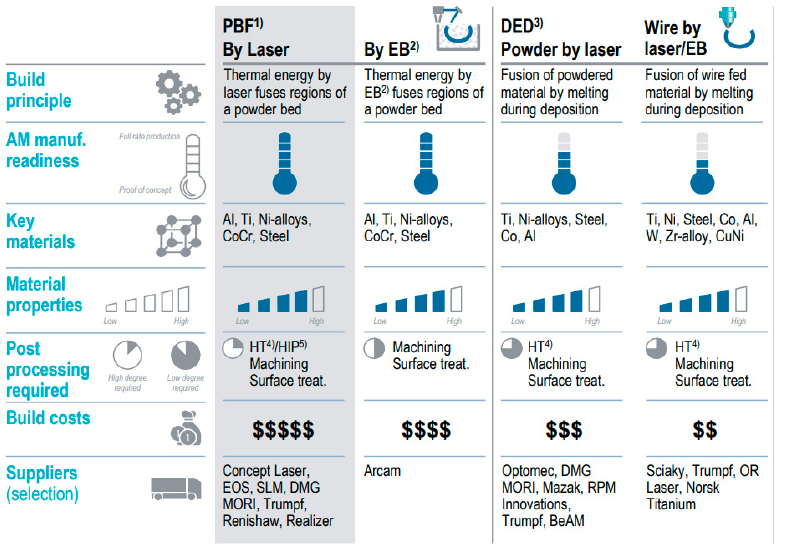
Figure 2. Additive manufacturing methods considered in process selection (extract of Roland Berger Report 2017).